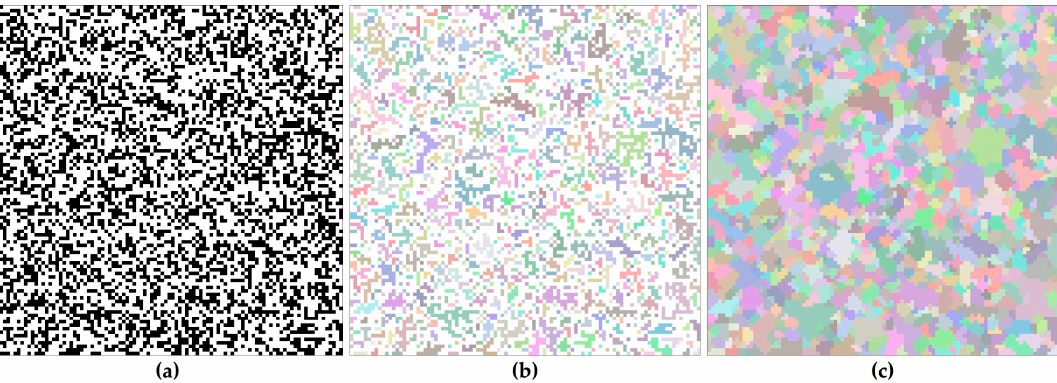
Figure 2. ( a ) A percolation map. ( b ) The clusters identified based on the 4-neighborhood criteria. ( c ) A cluster map with assigned unlabeled cells.